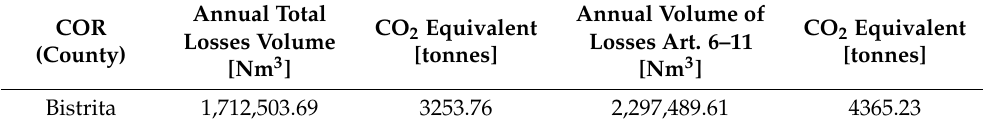
Table 4. CO 2 equivalent per year (source: authors based on the analysed data).